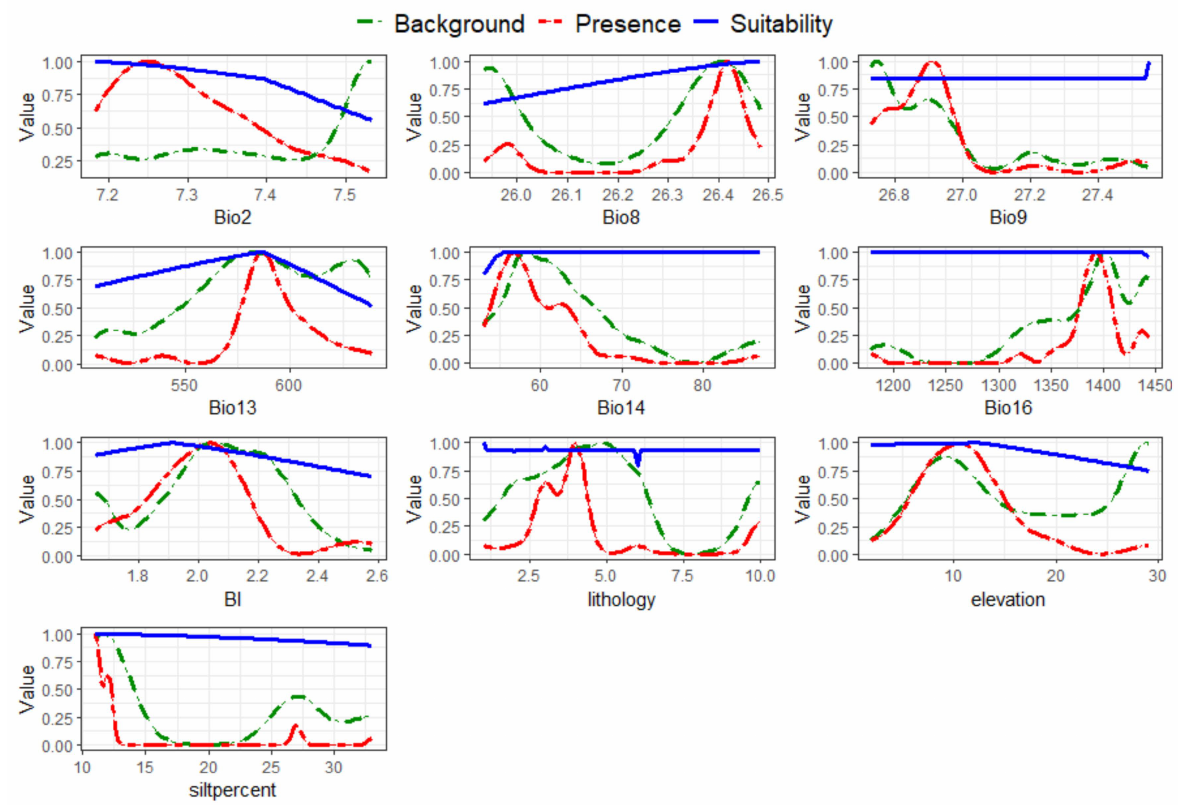
Figure 5. The model (ML1) response curve shows the density distribution of each environmental variable in the species occurrences and background data. The habitat suitability index ranges from 0 to 1, the red line is the response curve of the species presence, the green line is the background sample toward the environmental variables, and the blue line is the predicted habitat suitability. Note: the Y-axis represents the habitat suitability index and density distribution